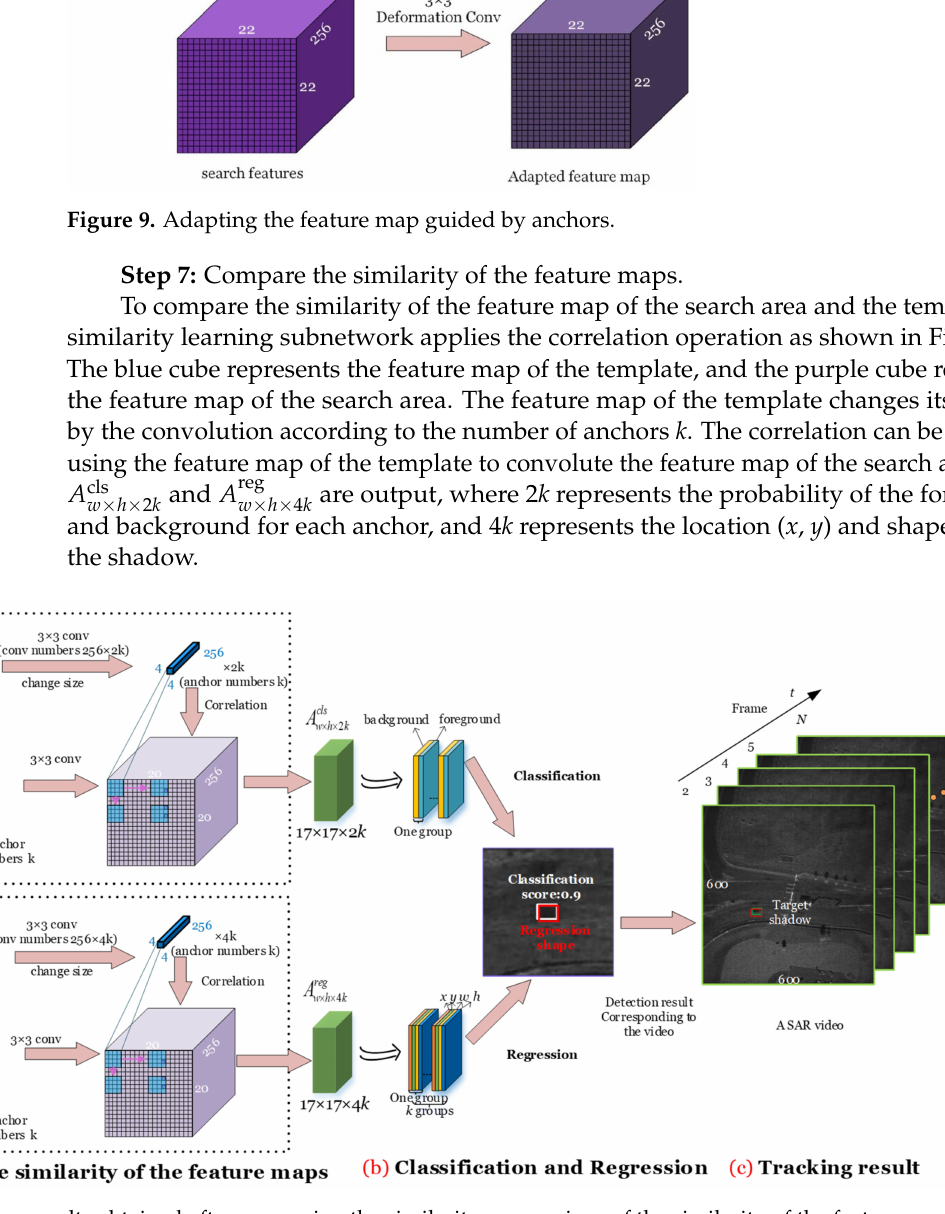
Figure 10. The tracking results obtained after comparing the similarity; comparison of the similarity of the feature maps ( a ), classification and regression ( b ), and tracking results ( c